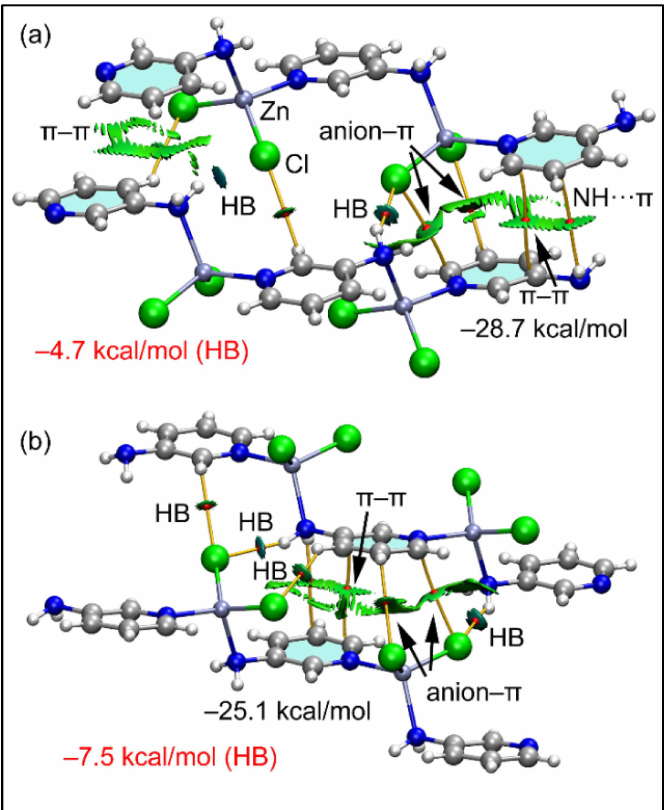
Figure 11. ( a , b ) QTAIM (bond paths in orange and bond CPs in red) and RDG surfaces of two dimeric models of compound 2 . The gradient cut-off is (cid:36) = 0.04 a.u., s = 0.35, and the color scale is − 0.04 a.u. < (cid:36) < 0.04 a.u. Only intermolecular interactions are represented. The total contribution of the H-bonds is also indicated, estimated using the Vr energy